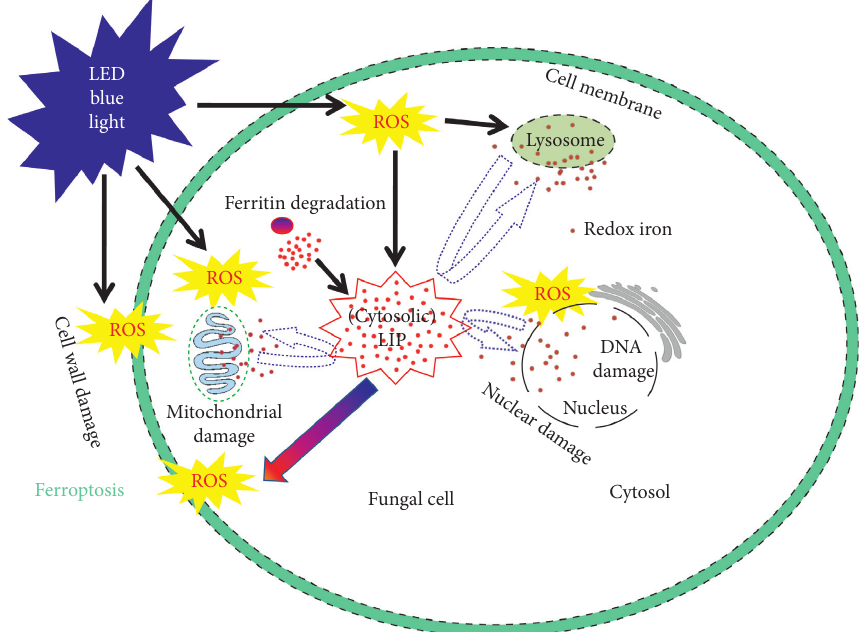
Figure 2: Blue light-induced ferroptosis in fungal